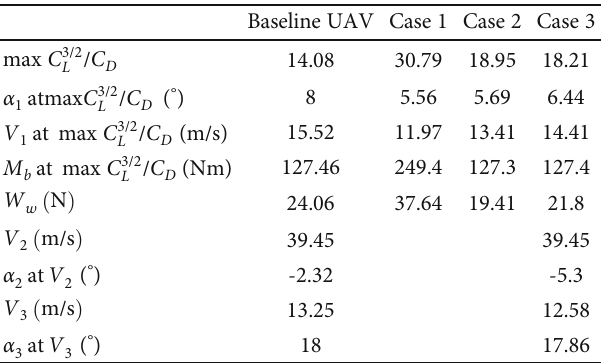
Table 4: Performance parameters of baseline UAV and the optimum UAVs.